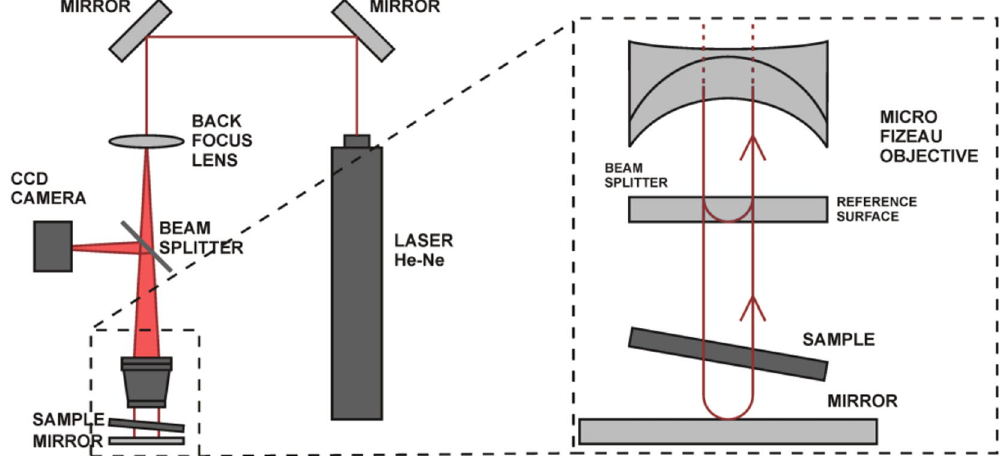
Figure 6. Laser interferometric microscope. Schematic representation of the operating principle of the laser interferometric